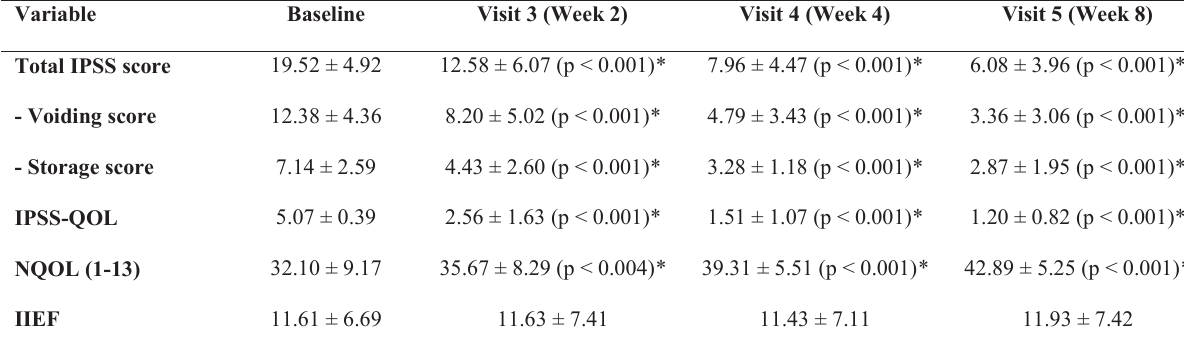
n=49 Data are presented as mean ± SD * p < 0.05 significant, Repeated measurement analysis of variance (ANOVA)